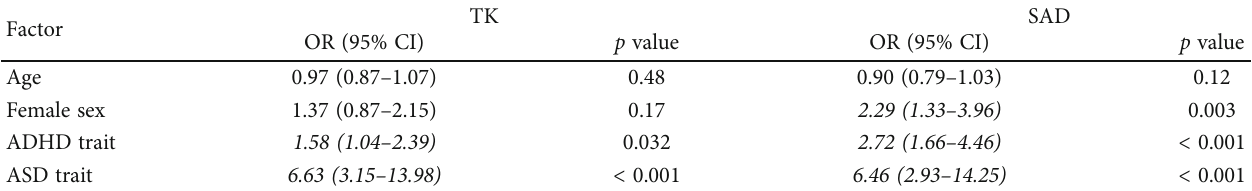
Table 2: Factors associated with TK and SAD on logistic regression analysis.